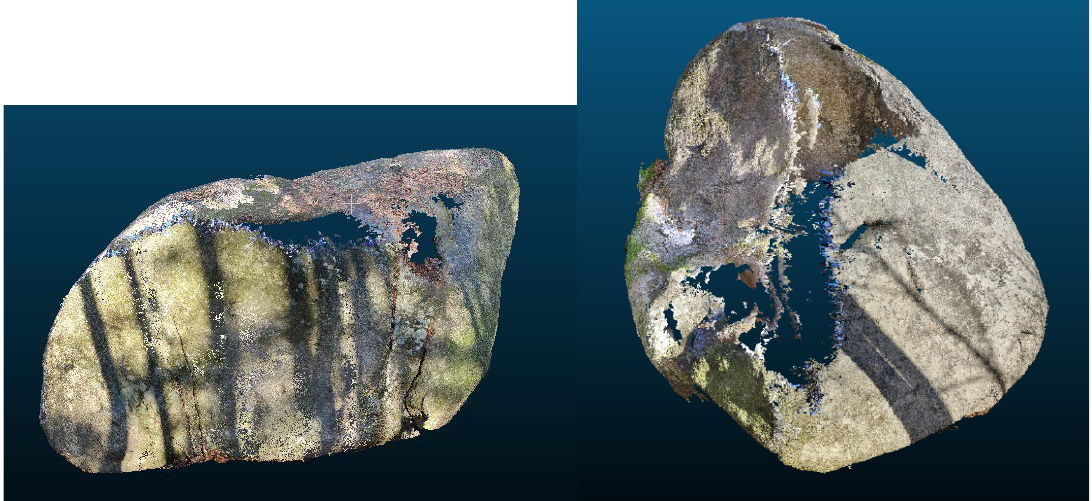
Figure 6. Models by AGISOFT PhotoScan (Boulder No.1 – left, boulder No.2 – right).